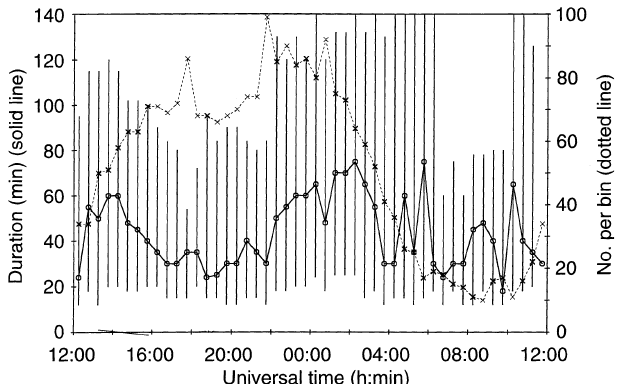
Fig. 3. Duration of identified intervals of ion frictional heating, as a function of universal time. The solid line represents the median duration, in each half-hour bin, with vertical lines which span the range of durations bounded by the upper and lower quartiles. The dotted line indicates the number of estimates of duration in each